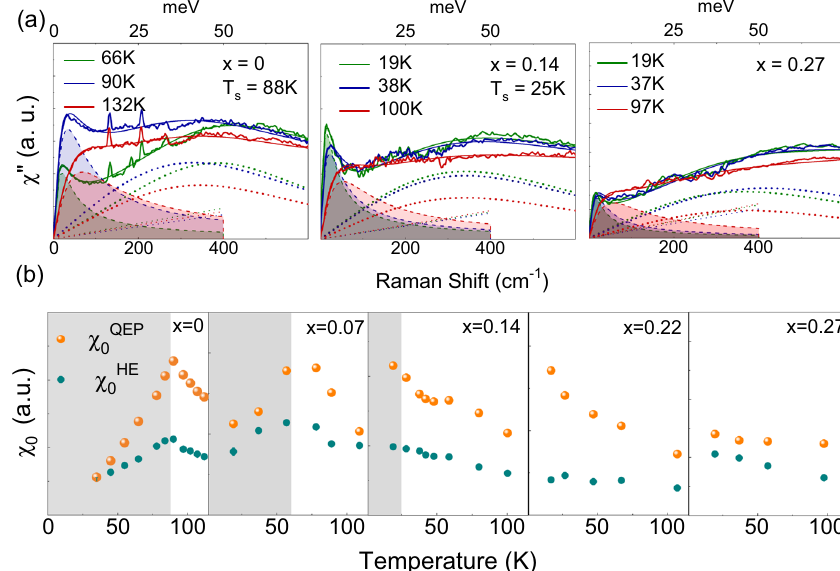
Fig. 3 Two component analysis of the nematic fl uctuation spectrum. a Decomposition of the B 1g Raman response illustrated at three different compositions: x = 0, x = 0.14, and x = 0.27 (see equation in the main text). The QEP peak component is highlighted via shading. b Temperature dependence of the two main contributions (QEP and HE) to the static nematic susceptibility χ 0 . Standard errors of the fi ts are shown but are usually smaller than the